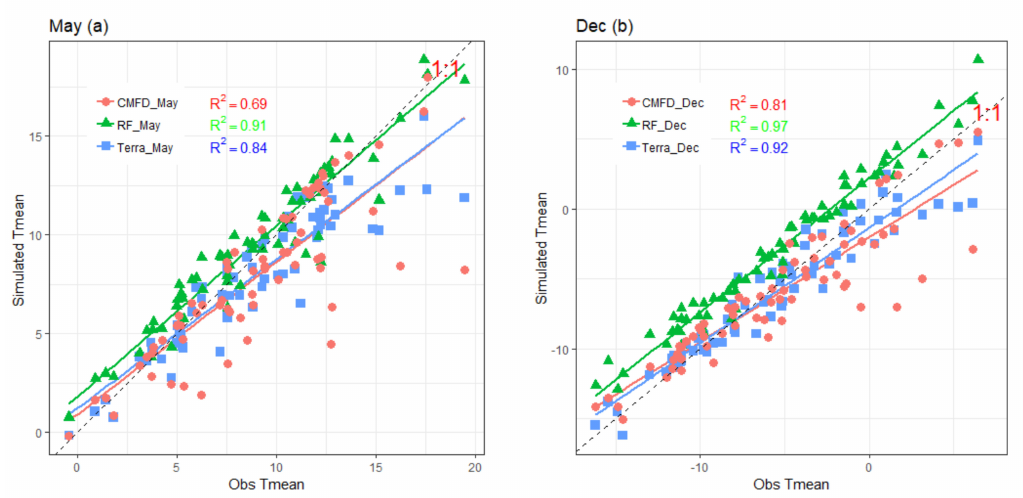
Figure 8. Comparison of monthly Tmean in May ( a ) and December ( b ) derived from Random Forest, TerraClimate and CMFD with the observed mean temperature of 1980–2010 from in situ measurements.